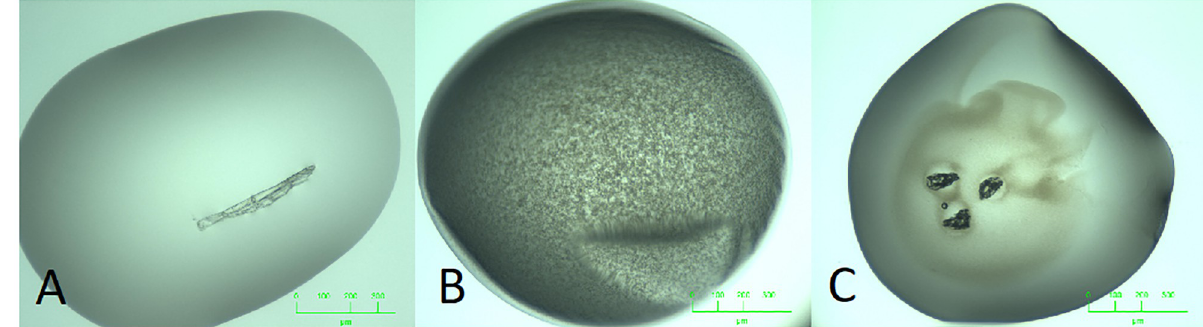
Fig 2. Outcomes not captured in the MARCO closed set. Many crystallisation images display outcomes that are not easily captured in four classes A: Dust fibre in an otherwise clear drop. B: Precipitated protein, along with an artifact from a wrinkled skin over the droplet. C. Collapsed air bubbles, (introduced inadvertently during drop dispensing) against a background of precipitated protein.